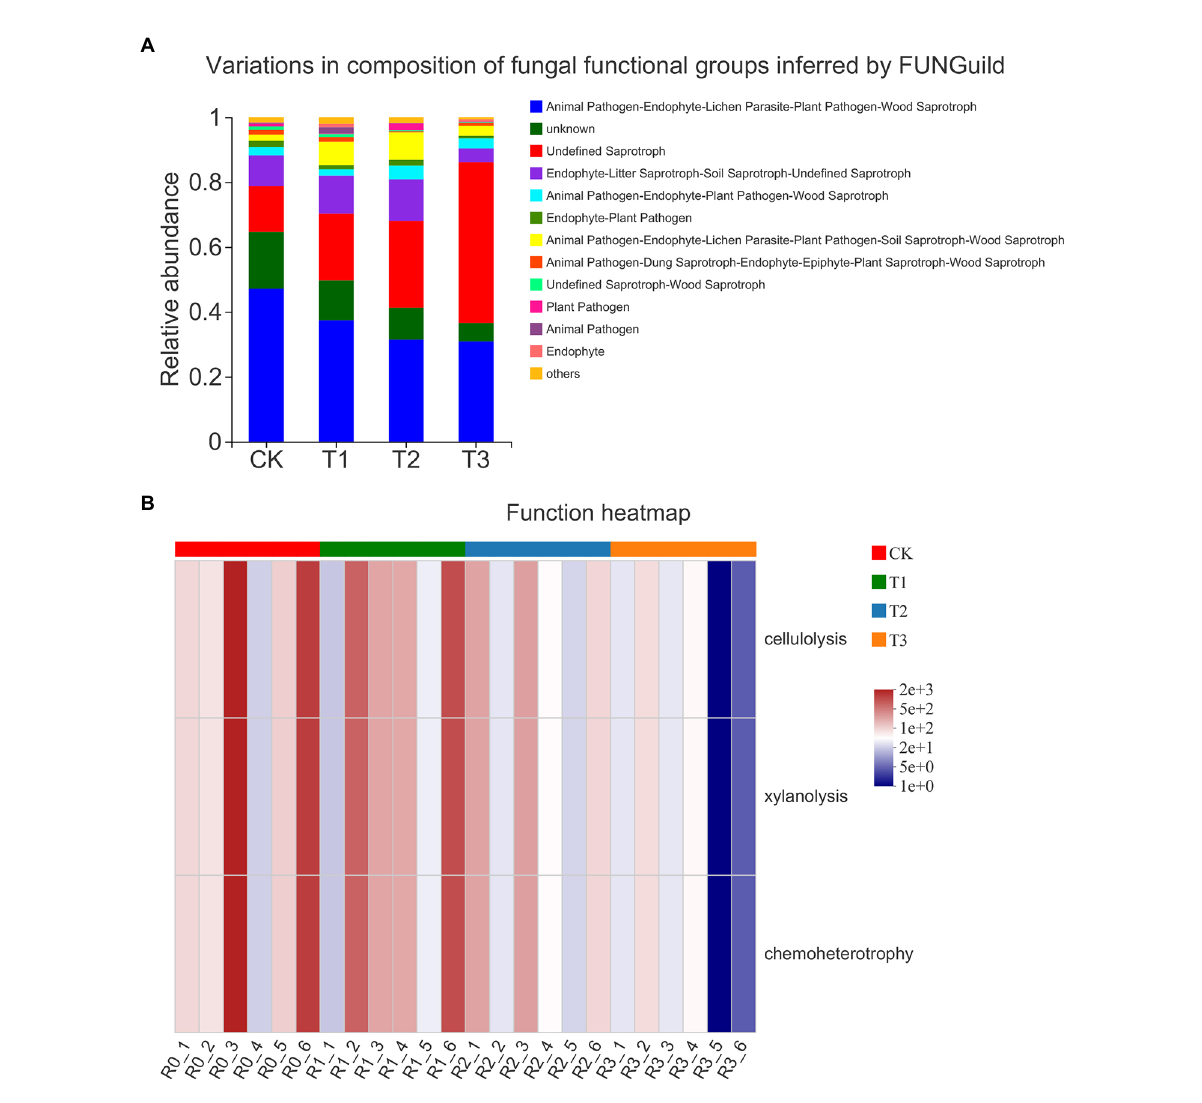
FIGURE 6 Taxonomic analysis of fungal communities by microecological guild (FUNGuild; A ) of different treatments. The functional heatmap predicated by FAPROTAX in fungi (B) under different treatments. n =